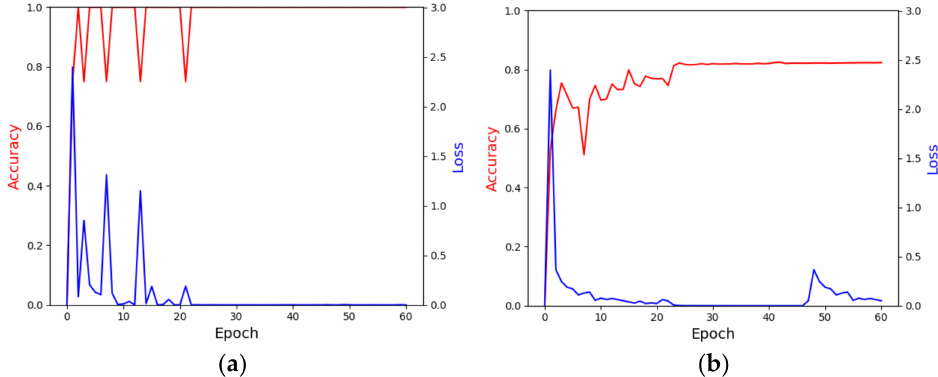
Figure 9. Training and validation loss and accuracy graphs of ResNet-101. ( a ) Training loss and accuracy graph. ( b ) Valida- tion loss and accuracy graph.